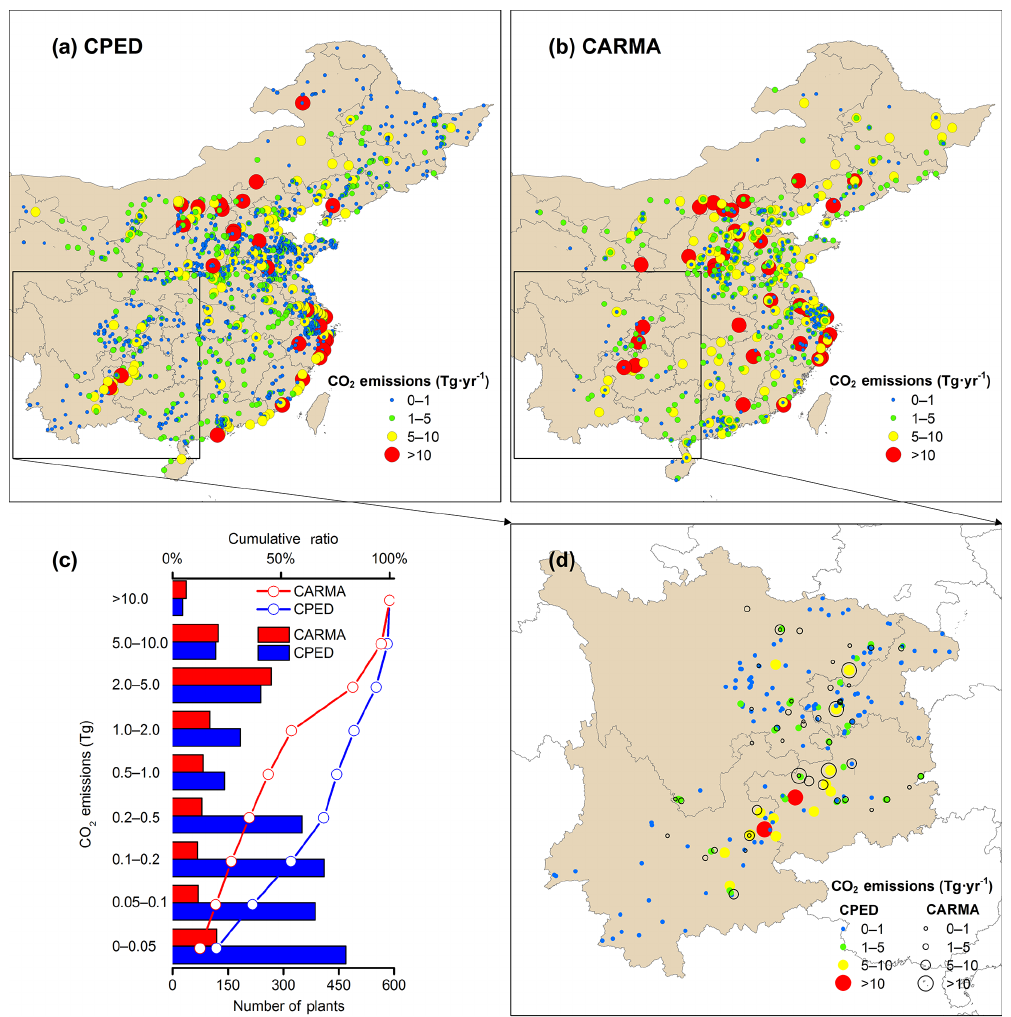
Figure 13. (a) Spatial distribution of CO 2 emissions in CPED in 2009. (b) Spatial distribution of CO 2 emissions in CARMA in 2009. (c) Comparisons of CO 2 emissions between CARMA and CPED by plant numbers in 2009. The plants are sorted according to ascending CO 2 emissions along the y axis. The red and blue lines denote the plant number cumulative ratio for CARMA and CPED, respectively. (d) Comparisons of the spatial distribution of CO 2 emissions in southwest China between CARMA and CPED in